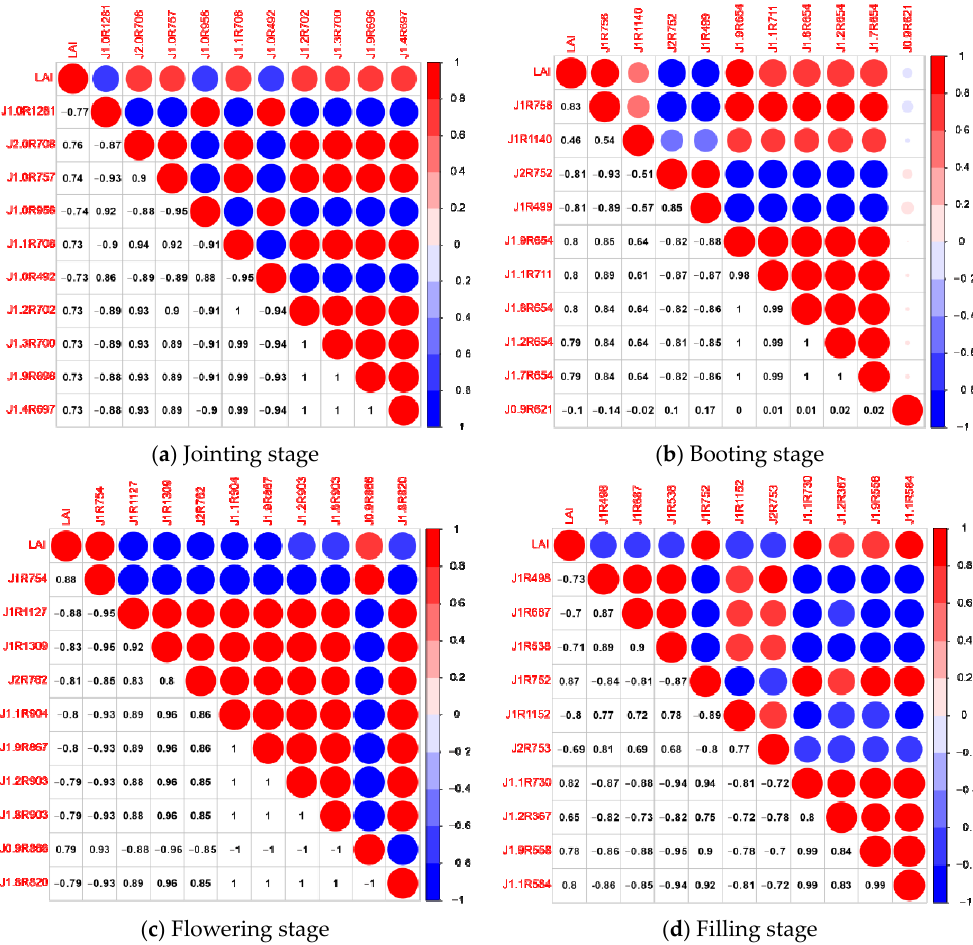
Figure 4. Correlation matrix diagram of selected fractional differentiation spectrum and leaf area index at different growth stages.